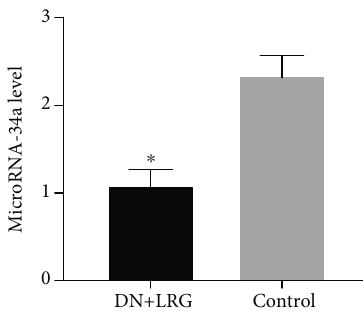
Figure 12: MicroRNA-34a expression in the livers. Control: diabetic nephropathy group; DN+LRG: diabetic nephropathy +liraglutide group. ∗ P < 0 : 05 vs. the